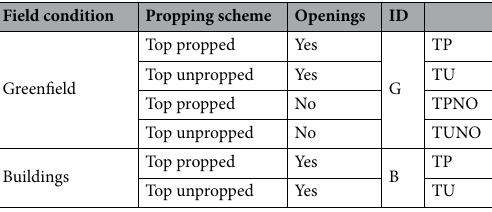
Table 4. Analysed cases.